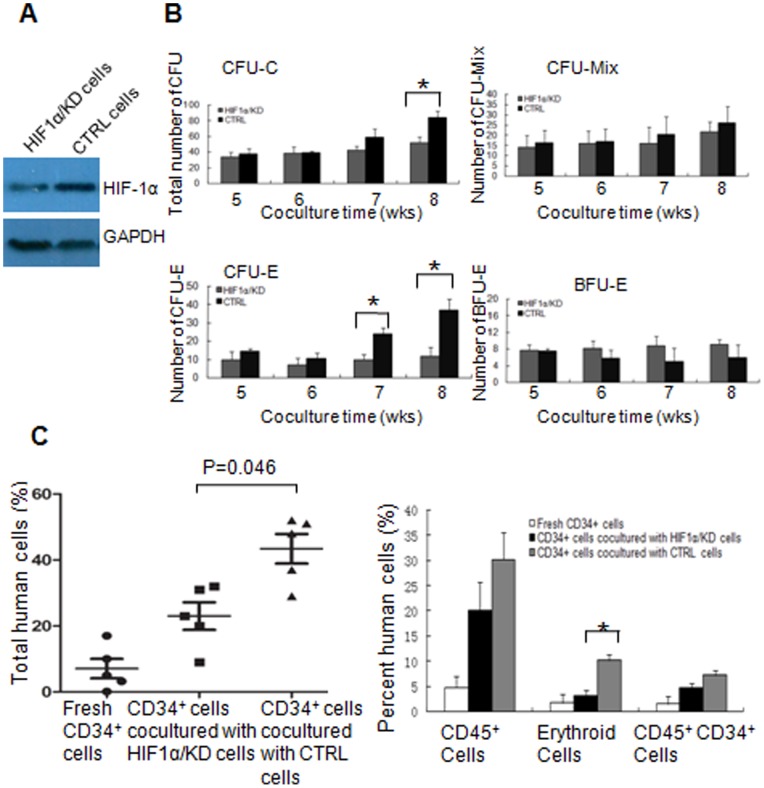
HIF-1α knockdown partially abrogates the hematopoietic supporting ability of osteoblastic miR-17.
A: Western blotting was performed to evaluate the expression level of HIF-1α protein in 17/OE cells after transduced with vectors for HIF1α knockdown (HIF1α/KD), or control (CTRL). B: The effect of the HIF1α/KD cells on long-term culture initiating cells activity of CB CD34+ cells. 1.0×104 CD34+ CB cells were co-cultured with HIF1α/KD cells or CTRL for 5-8 weeks and then subject to CFU assay. After 14–16 days of culture, the colonies, including CFU-Mixs, CFU-E, and BFU-E with greater than 50 cells were counted. The results are expressed as mean ± SD (n = 6). *p<0.05, compared between HIF1α/KD and CTRL group (Student’s t-test). C: Effect of HIF1α/KD cells on repopulation of CB CD34+ cells in non-obese diabetic/severe combined immunodeficient disease (NOD/SCID) mice. 5.0×104 CB CD34+ cells were co-cultured with HIF1α/KD or CTRL cells, harvested at 4 weeks of culture and then injected intravenously into the sublethally irradiated NOD/SCID mice (n = 6 per group). The mice were sacrificed 12 weeks after transplantation and the mononuclear cells from bone marrow were analyzed for human cells composed of CD45+, CD45–CD36+ and CD36–GPA+ cells and CD45+CD34+ population by flow cytometry. The level of total human cell engraftment was shown in the left panel. p = 0.046, compared between the mice injected with CD34+ cells co-cultured with HIF1α/KD and those injected with CD34+ cells co-cultured with CTRL (Student’s t-test). The fraction of CD45+, erythroid (CD45−CD36+ and CD45− CD36−GPA+) and CD45+CD34+ cells among the engrafted human cells was shown in the right panel. *p<0.05, compared between the mice injected with CD34+ cells co-cultured with HIF1α/KD and those injected with CD34+ cells co-cultured with CTRL (Student’s t-test). The significant difference was only analyzed between the mice injected with CD34+ cells co-cultured with HIF1α/KD and those injected with CD34+ cells co-cultured with CTRL.